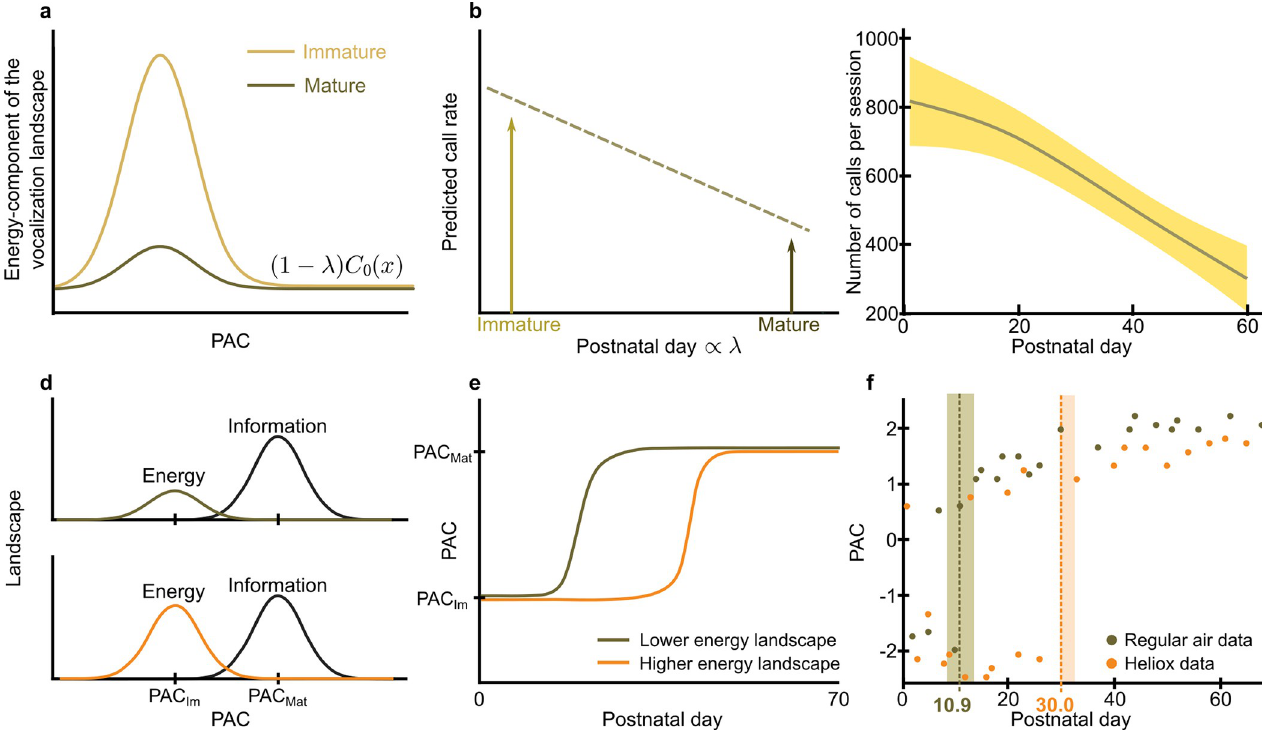
Fig 4. Energy metabolic cost is related to the immature component of the vocalization landscape. a. Schematic of how the predicted energy component of the vocalization landscape, (1 − λ ) C 0 ( x ), varies from immature ( λ closer to 0) to mature ( λ closer to 1) phases of development, being higher during the mature stage. λ is the parameter that controls the balance between landscapes. C 0 ( x ) is the component of the landscape which relevance decreases during development. b. Expected decrease in call rate. c. Observed decrease in call rate. The shaded region represents a 95% confidence interval. d. Schematic of two situations with different energy component of the landscape C 0 ( x ): the plot on the top represents a lower energy landscape; the plot on the bottom represents a higher energy landscape. The black line represents the information landscape, C 1 ( x ), and is assumed to be constant in the two scenarios. e. Predicted vocal dynamics, measured by the optimal PAC, for the two scenarios, showing that lower energy landscapes predict faster transition. f. Observed vocal dynamics from the heliox setup in marmosets. Dashed lines represent transition day T air for regular air data and T heliox for heliox data. T air < T heliox with p <